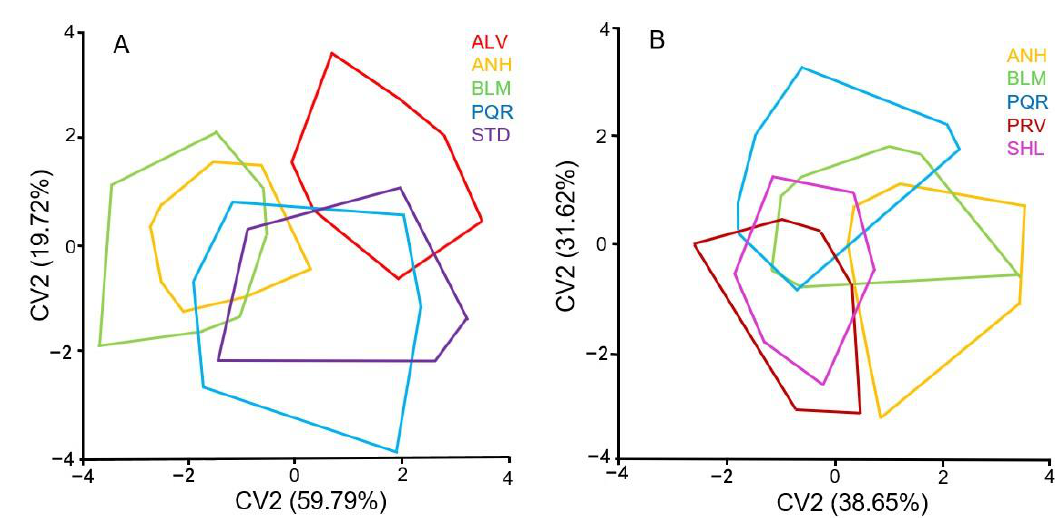
Figure 3. Morphospace produced by CVA of the wing shape of Ae. scapularis ( A ) and Ae. albopictus ( B ) populations.